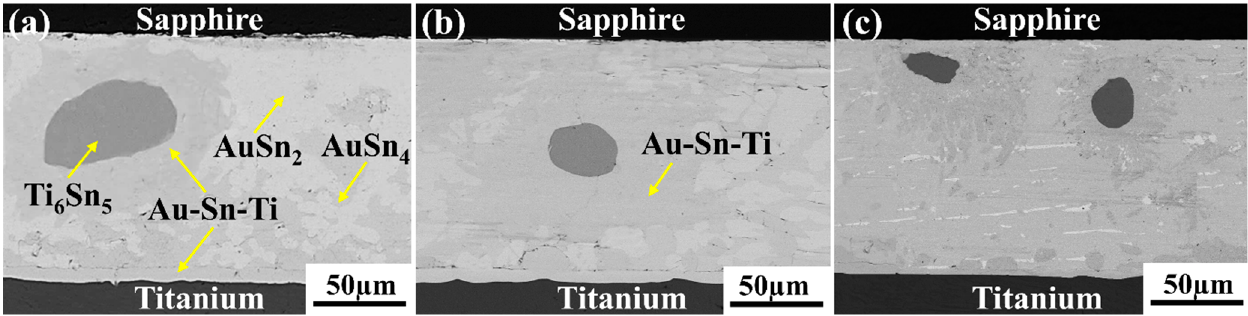
Figure 6. Interfacial microstructure of the titanium/AuSn20/Sn-3Ti/sapphire joints brazed at 550 °C for ( a ) 20 min, ( b ) 25 min, and ( c ) 35 min.